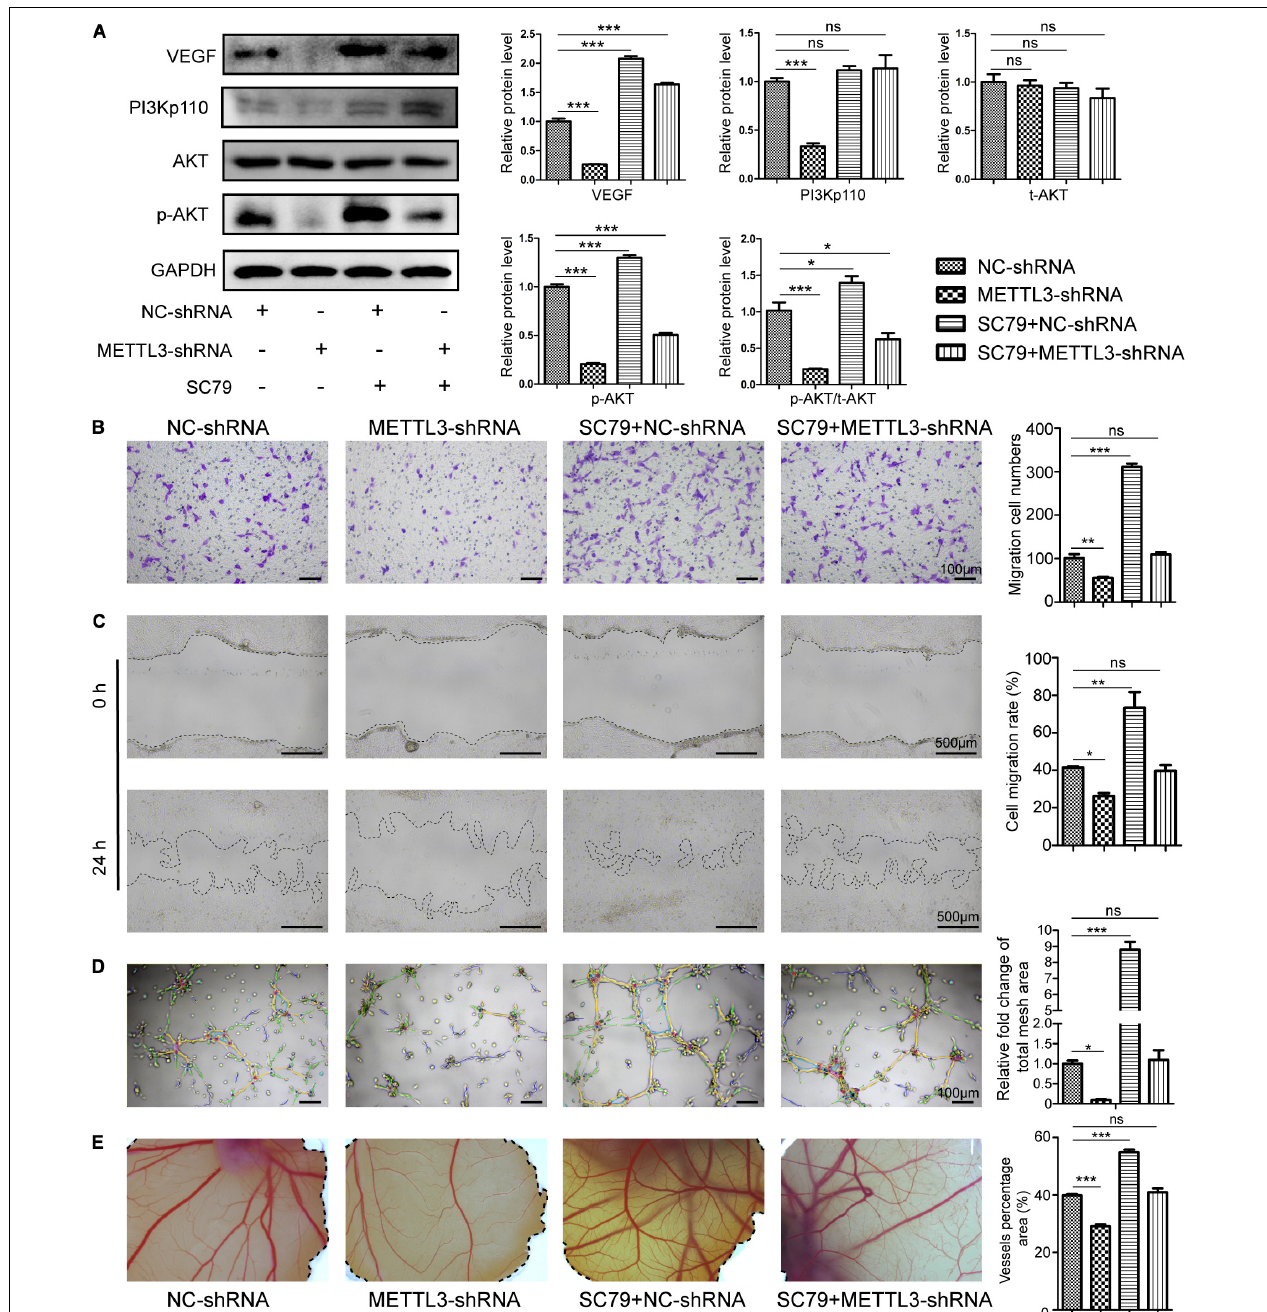
FIGURE 4 | Methyltransferase-like 3 regulates EPC angiogenesis via activating the PI3K/AKT pathway. (A) Western blotting analysis of PI3K/AKT pathway proteins in negative control and METTL3-deficient EPCs which were treated with SC79. (B–E) Migration assay (B,C) , Tube formation (D) , and CAM angiogenesis assays (E) were conducted using negative control and METTL3-deficient cells after SC79 treatment. Scale bars: 100 and 500 µ m. These results indicated that injection with METTL3-knockdown EPCs was sufficient to reduce EPC angiogenic activity, whereas SC79 was able to reverse such impairment. Data are means ± SD and were compared via one-way ANOVA with Tukey’s post hoc test. ns P > 0.05, * P < 0.05, ** P < 0.01, *** P < 0.001 vs. NC-shRNA; n = 3 per group, experiments were repeated in triplicate.